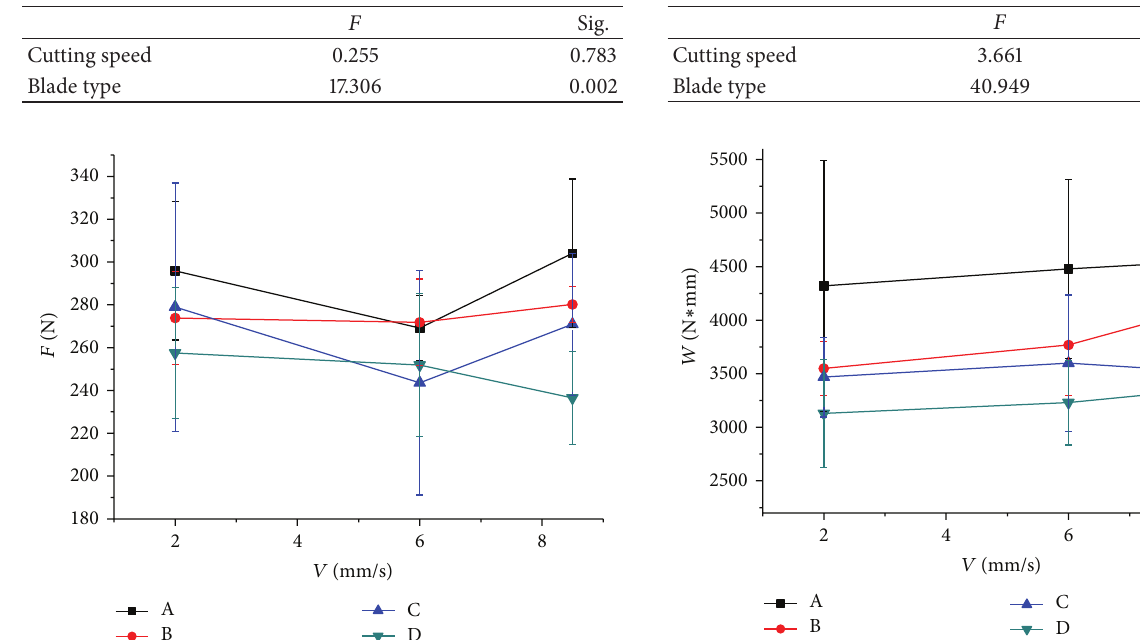
Table 6: 𝐹 test results—dependent variable: work.